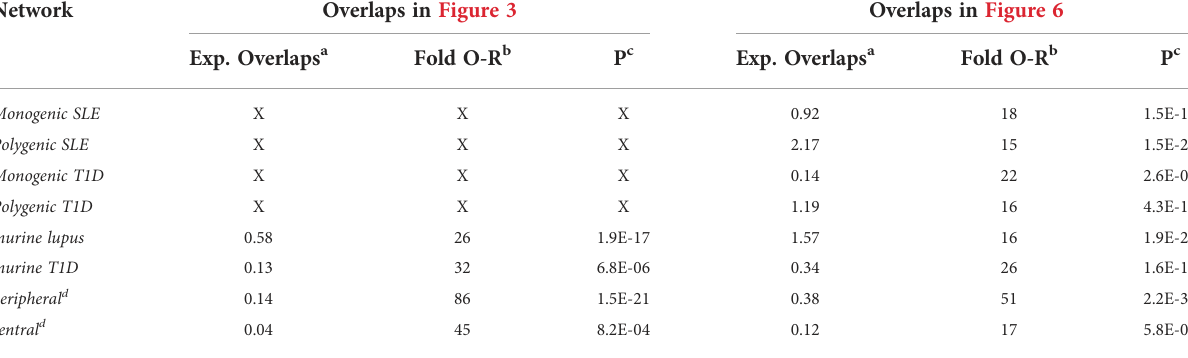
TABLE 3 Overlaps of disease networks supporting Figures 3 (Murine T1D, Lupus, Peripheral and Central tolerance) and Figure 6 (all 8 networks combined).